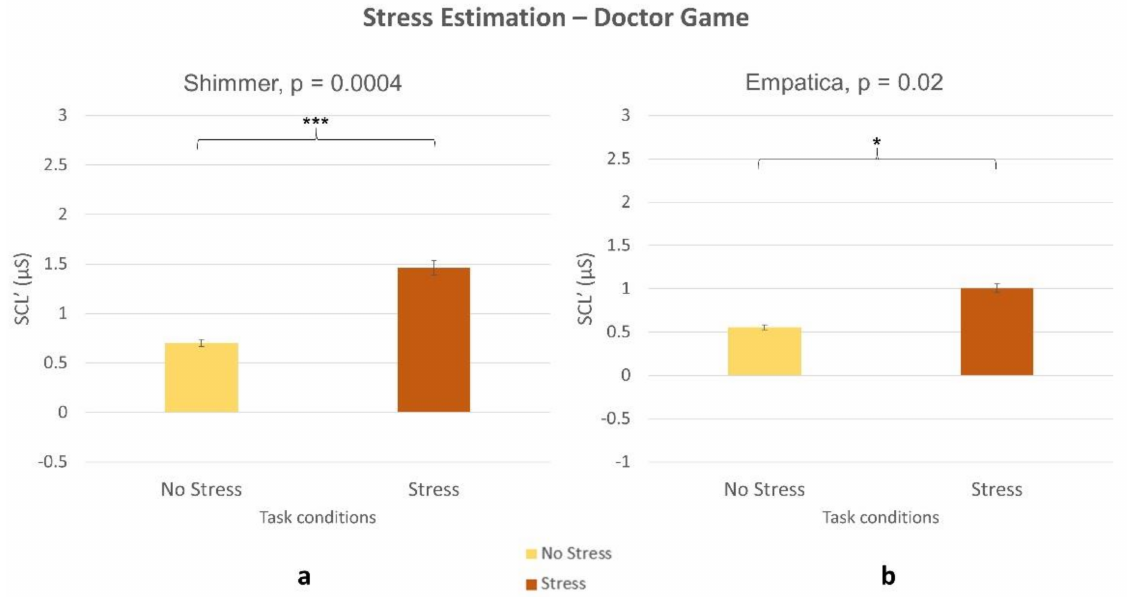
Figure 14. Increased SCL’ in stress vs. no stress condition during DG task. Statistical analysis revealed significant difference between the conditions for both ( a ) laboratory equipment ( p = 0.0004) and ( b ) wearable device ( p =